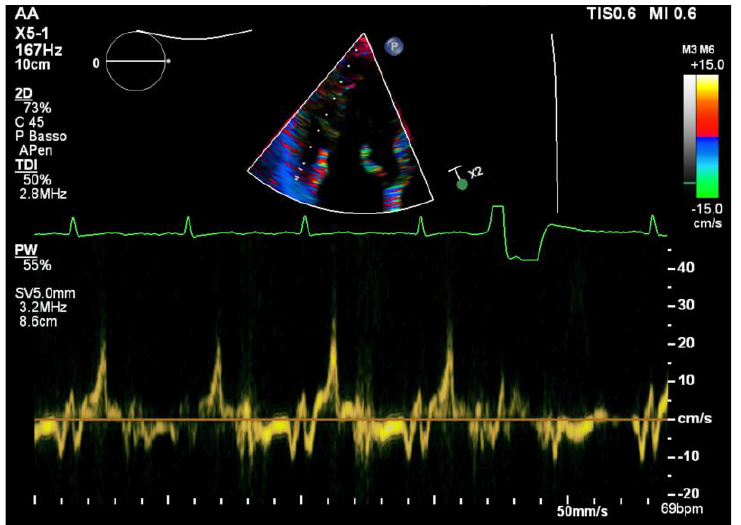
Figure 2. A pulsed wave tissue Doppler signal on the basal inferolateral wall from the same patient of Figure 1 (aMVP group). Note the spiked high velocity signal (Pickelhaube sign).